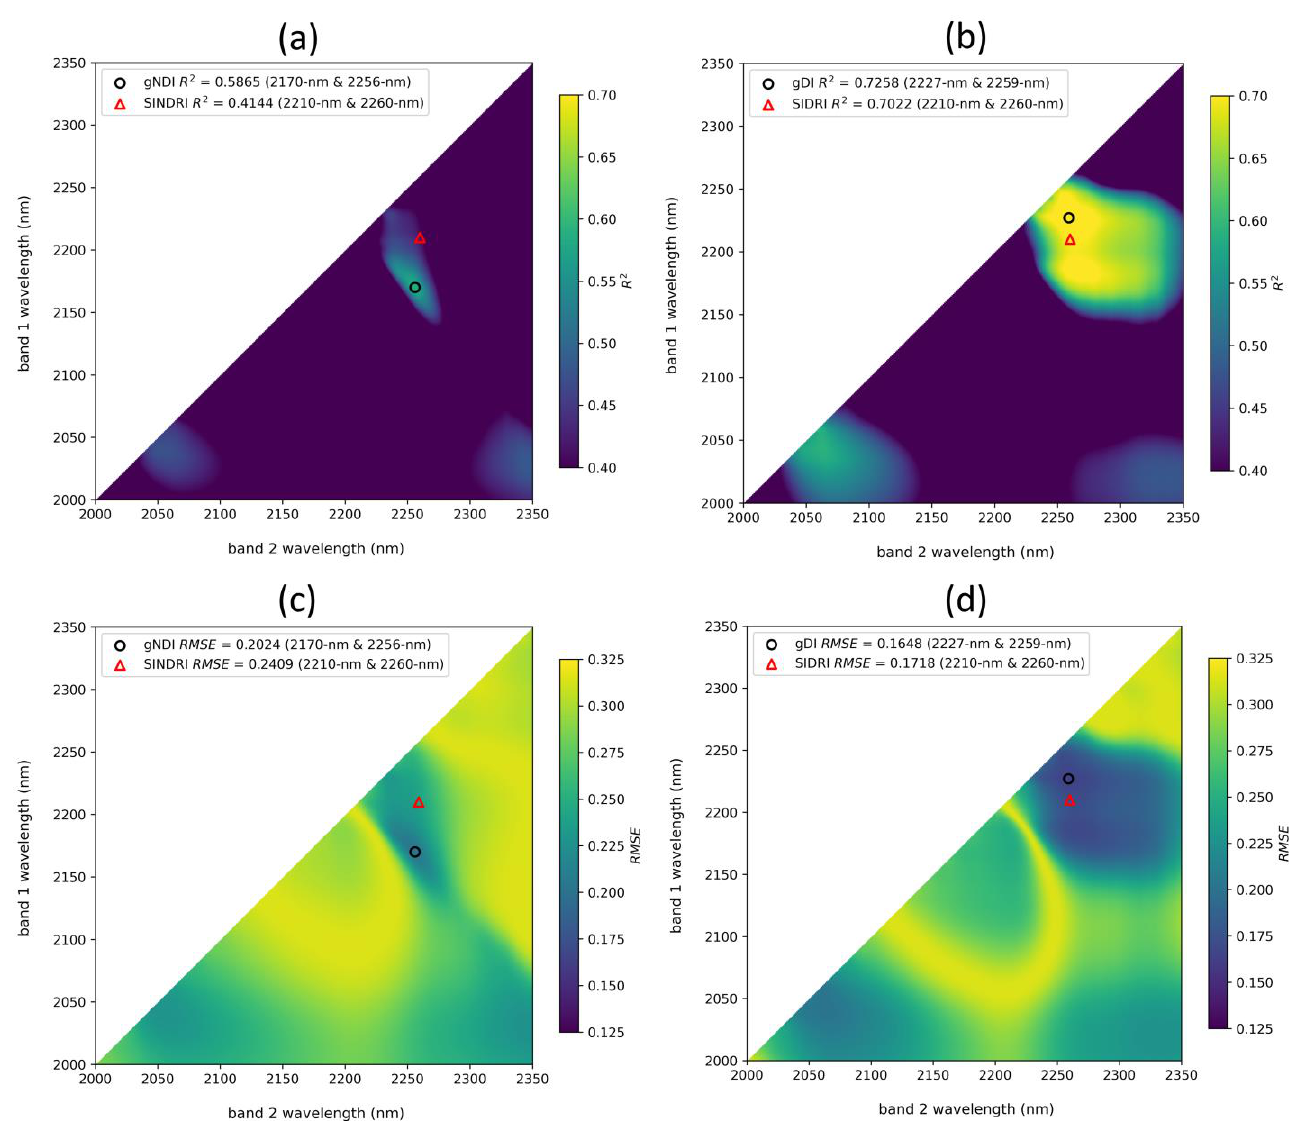
Figure 5. Performance metrics for two-band gNDI and gDI using 1 nm interval full-NDVI dataset with n = 916: ( a ) gNDI- R 2 , ( b ) gDI- R 2 , ( c ) gNDI- RMSE , ( d ) gDI- RMSE . All spectra were processed to surface reflectance. In all panels, the black circles represent the band combination that produced the best f R estimation performance, as defined by the respective performance metric. The red triangles depict the band combination of a comparable heritage index. Table 2. Two-band wavelength shift analysis performance for 1 nm interval (30 nm bandwidth) BARC dataset. For nearly all statistical performance metrics ( R 2 , RMSE ), the 1 nm interval dataset results demonstrate higher explained variance and lower error than the 10 nm dataset in f R estima- tion but identify very similar top-performing bands (see Table 1). Band-1 and Band-2 denote the wavelengths with the highest f R estimation performance for both R 2 and RMSE. Top-performing bands and indices for each NDVI case have been bolded.